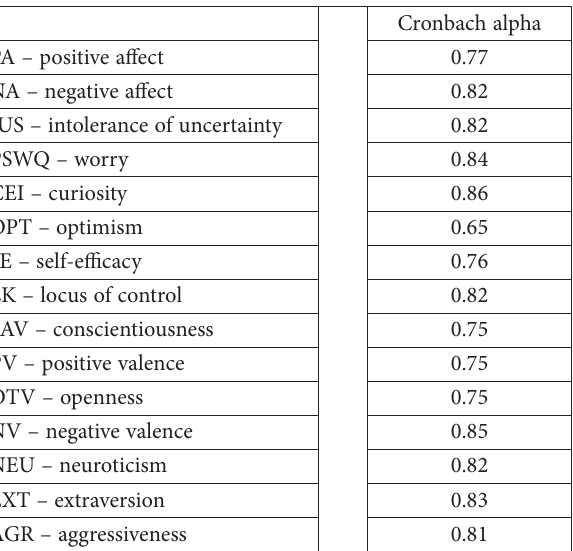
Table 2. Reliability of the